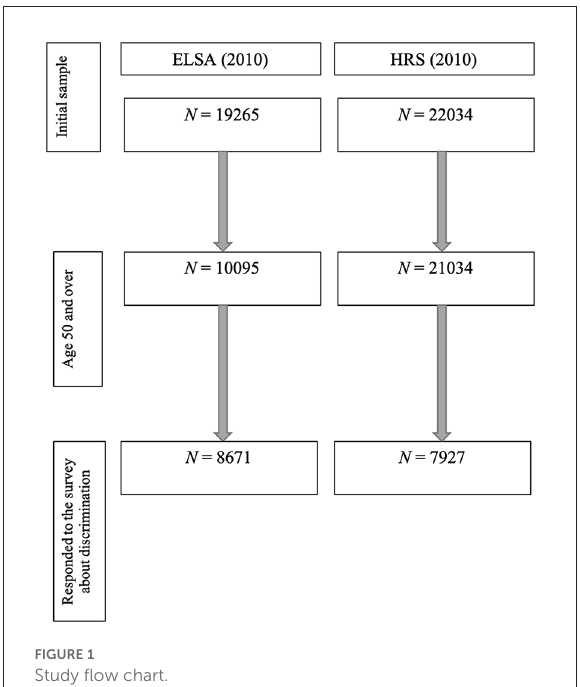
FIGURE1 Study flow